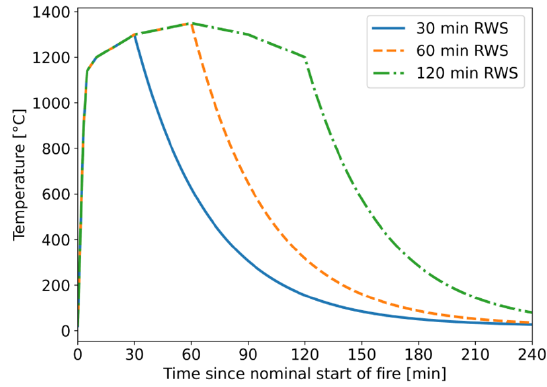
Figure 2. Example fire curves. RWS heating phase and exponential decay phase. Temperatures to be interpreted as adiabatic surface temperatures.